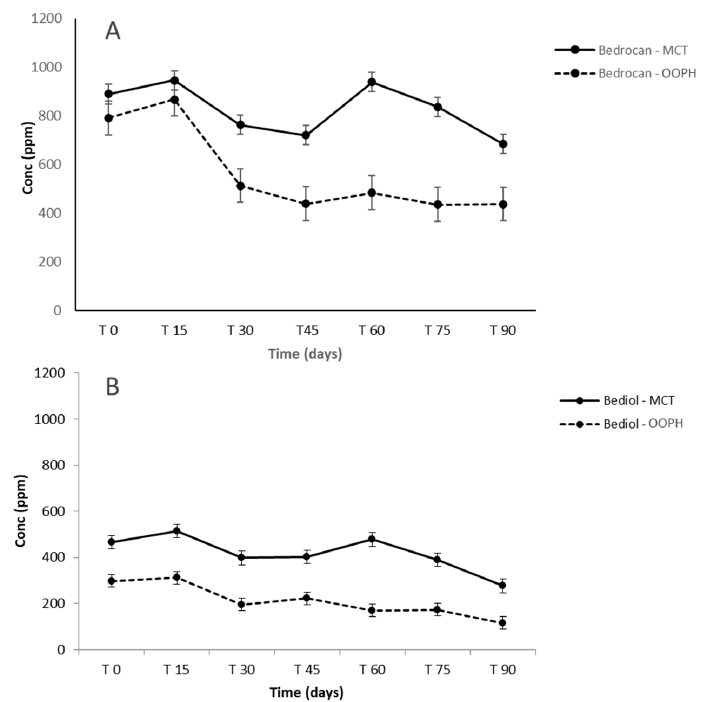
Figure 6. Concentration of the total extracted amount of terpenes (ppm) in Bedrocan ® ( A ) and Bediol ® ( B )-based oils as a function of the storage time and lipid sources: PhEur-grade olive oil (OOPH) and medium-chain triglycerides (MCTs).